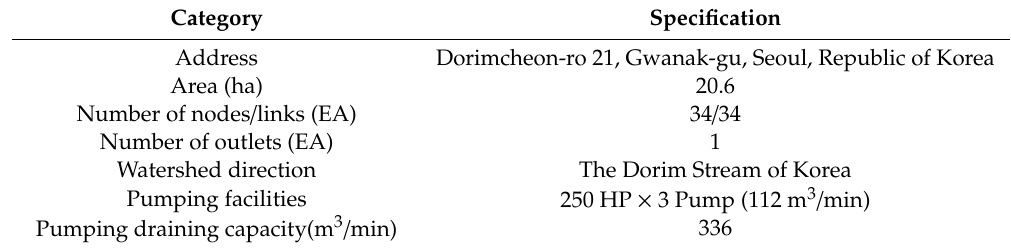
Table 4. Subcatchment Properties of the study area including the pumping station